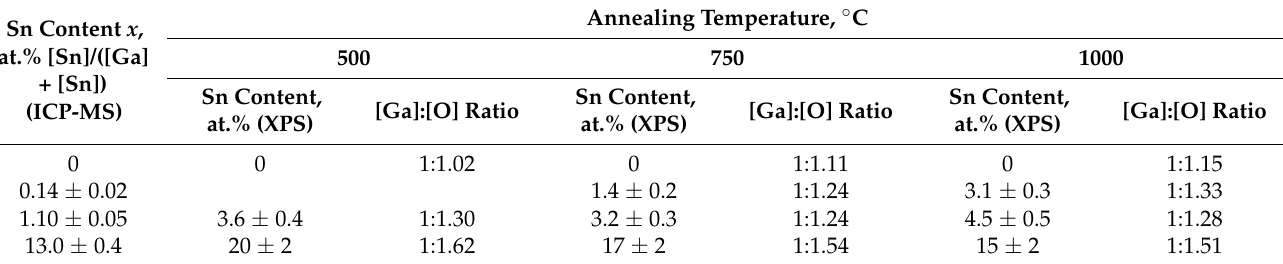
Table 2. XPS characterization of Ga 2 O 3 (Sn) samples.